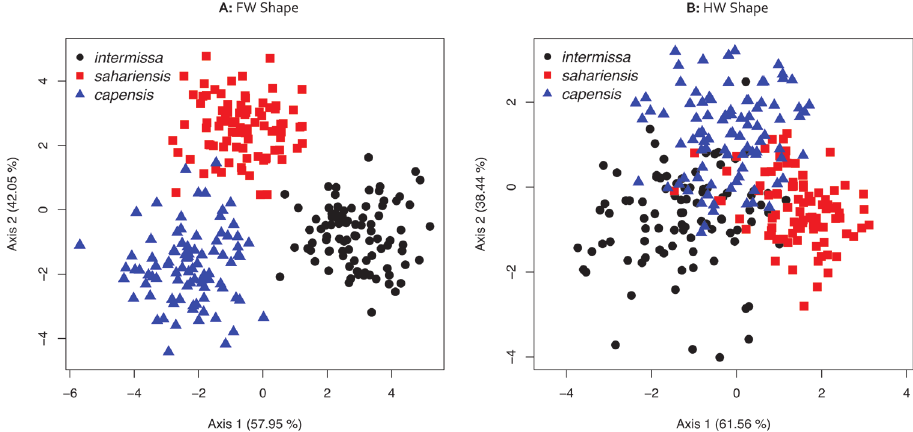
Figure 3. Shape variability among Apis mellifera intermissa, A. m. sahariensis and A. m. capensis : first two canonical variates. A fore wing shape B hind wing